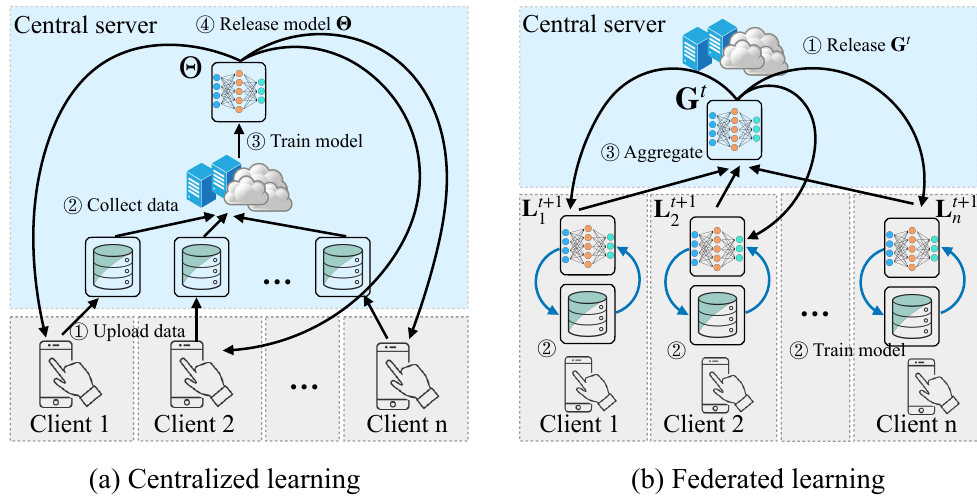
Figure 1. Flowchart of centralized learning and federated learning framework. ( a ) Clients upload local dataset to a trust central server, ( b ) while, in the federated learning system, clients keep their private data